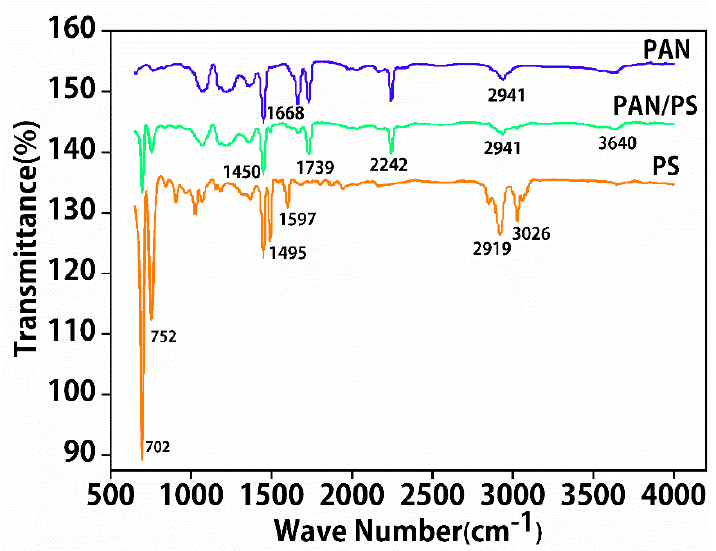
Figure 3. FTIR spectra of PAN nanofibers and PAN/PS composite nanofibers.